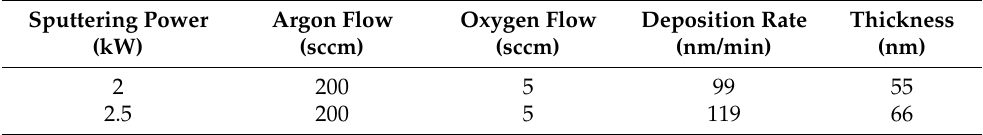
Table 2. The deposition rate and thickness of Ti 3 O x thin film deposited at 2- and 2.5 kW. Sputtering